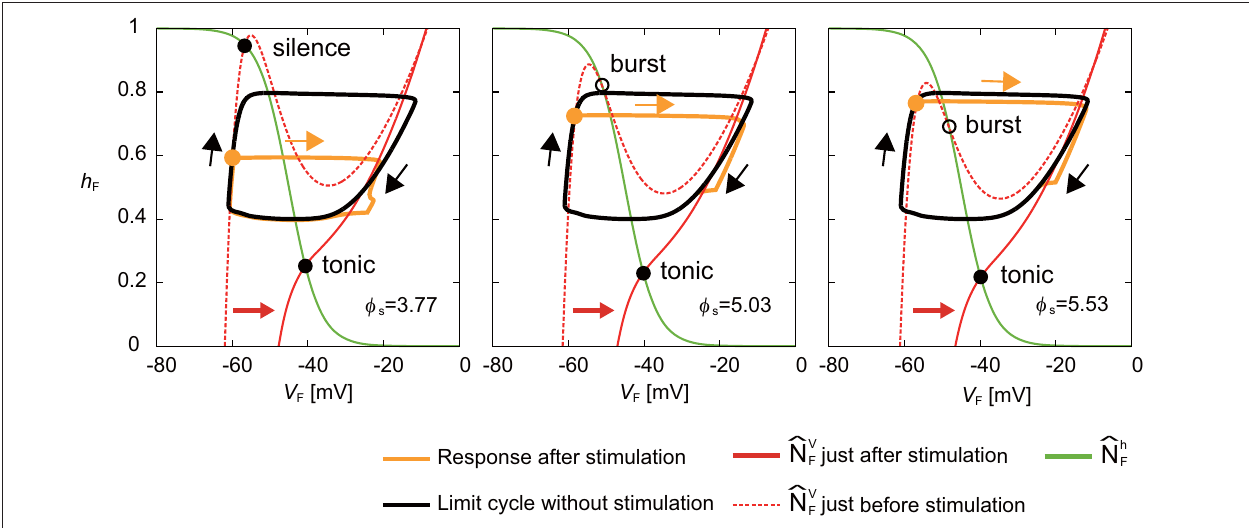
FIGURE 5 | Response of a RG-F neuron on the V F - h F plane by stimulating the flexor side at φ s = 3.77, 5.03, and 5.53rad. The black line shows the limit cycle without stimulation. Stimulation is applied at filled orange circles. Disturbed trajectories (orange line) take a shortcut to enter the limit cycle at different positions depending on φ s . Earlier φ s has a larger truncated trajectory. The green line shows ˆ N h F . The red dashed and solid lines show ˆ N V F just before and after the stimulation, respectively. The intersection of ˆ N h F and ˆ N V F changed from silence or burst mode to tonic mode by the